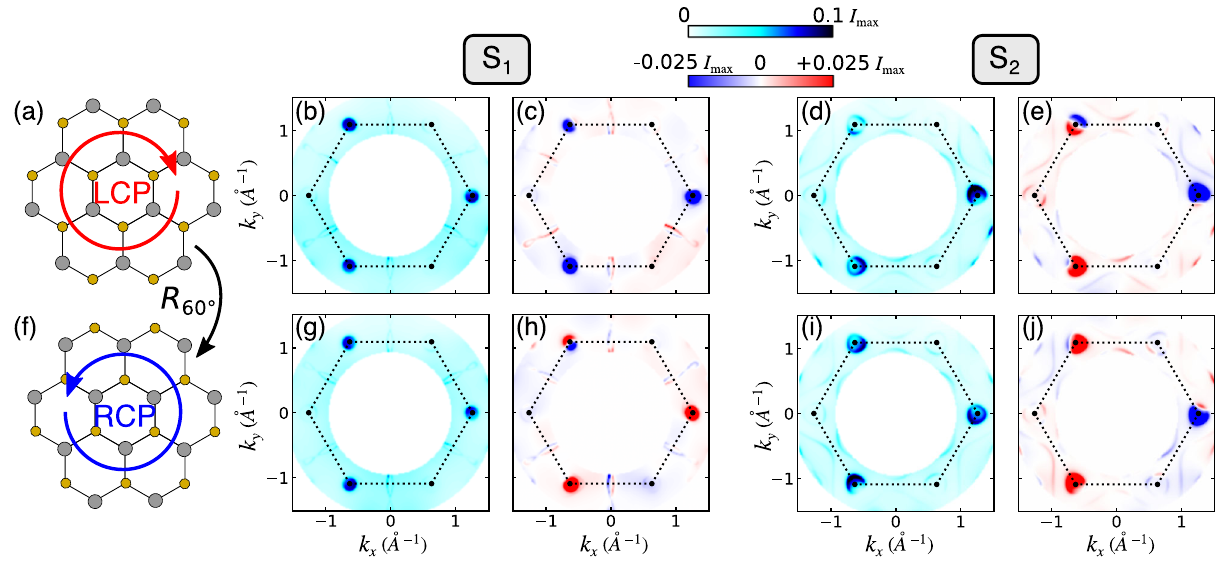
Fig. 5 Intensity and circular dichroism of Floquet side bands. a Sketch of the sample orientation and left-hand circular polarization (LCP) of the pump for the spectra in b – e . b Photoemission intensity at a fi xed-energy cut through the side-band S 1 ; c corresponding circular dichroism. d , e Analogous plots of intensity and circular dichroism for a fi xed-energy cut through the side-band feature S 2 . f Sketched of rotated sample and right-hand circular polarization (RCP) of the pump, which is the setup for the spectra in g – j . The intensity for S 1 /S 2 is shown in g , i , while the circular dichroism is presented in h , j . The binding energy E is chosen to maximize the intensity; the pump fi eld strength is E 0 = 2 × 10 − 3 a.u., corresponding to Fig. 3b.